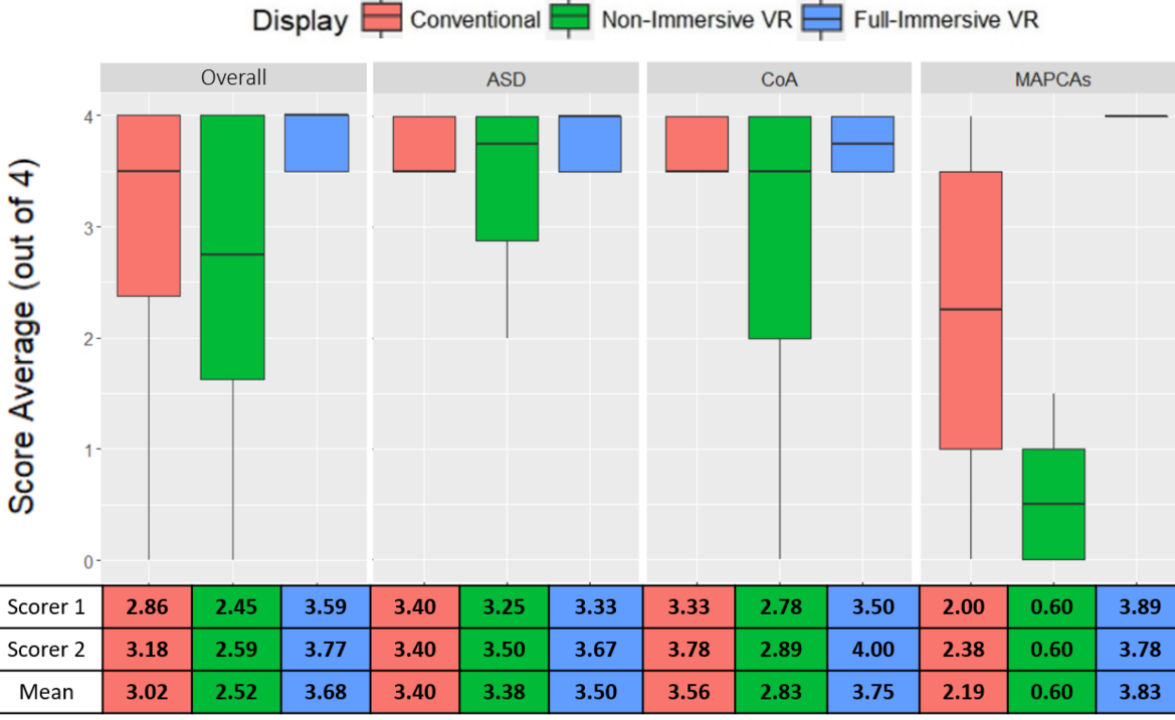
Figure 5. Diagnostic accuracy scores by type of congenital heart disease and display system (top) and by cardiologist (bottom). VR: virtual reality;